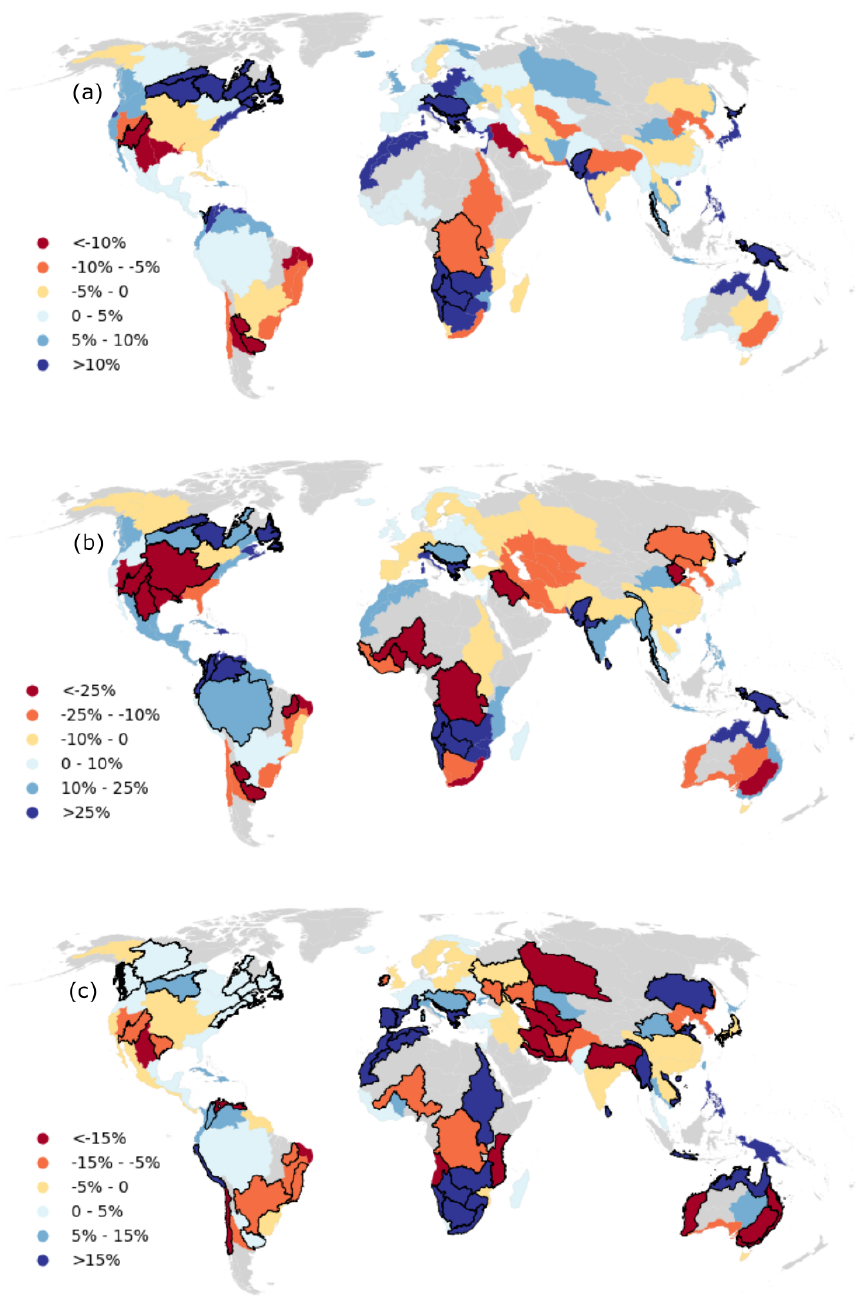
Figure 7. Linear trends in annual, basin-average (a) precipitation, (b) simulated streamflow, and (c) reservoir storage between 1984–2015 (gray shade: no reservoir data; black outlines: trend significant at p < 0 .